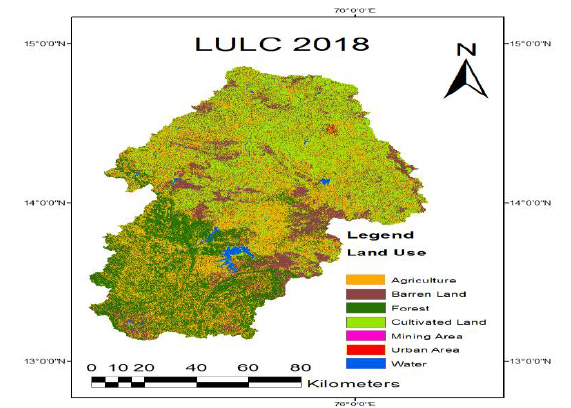
Figure 6 Land use land cover map of 2003